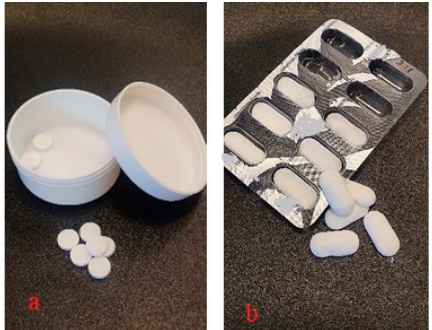
Figure 5. The physical appearance of ODx (( a )—prepared by direct compression, ( b )—prepared by freeze-drying).